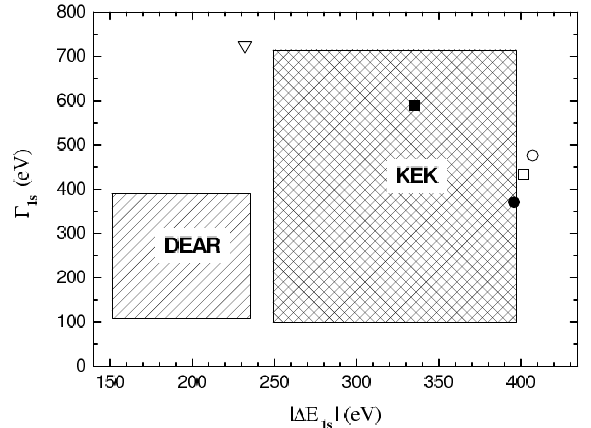
Fig. 3. DEAR and KEK 1 σ confidence region of kaonic hydro- gen 1 s level shift | ∆ E | (absolute value) and width Γ . The obtained theoretical results for the one-pole (solid circle) and two-pole (empty circle) variants of the potential are shown. The results of other theoretical models are also depicted: [9] (solid square), [10] (empty sqare), and [21] (empty triangle).